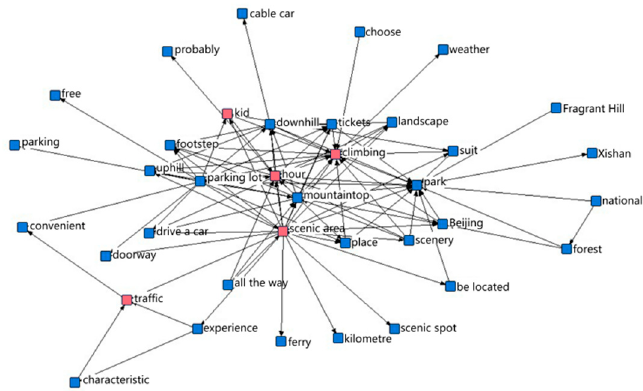
Figure 9. The semantic network of positive evaluations.